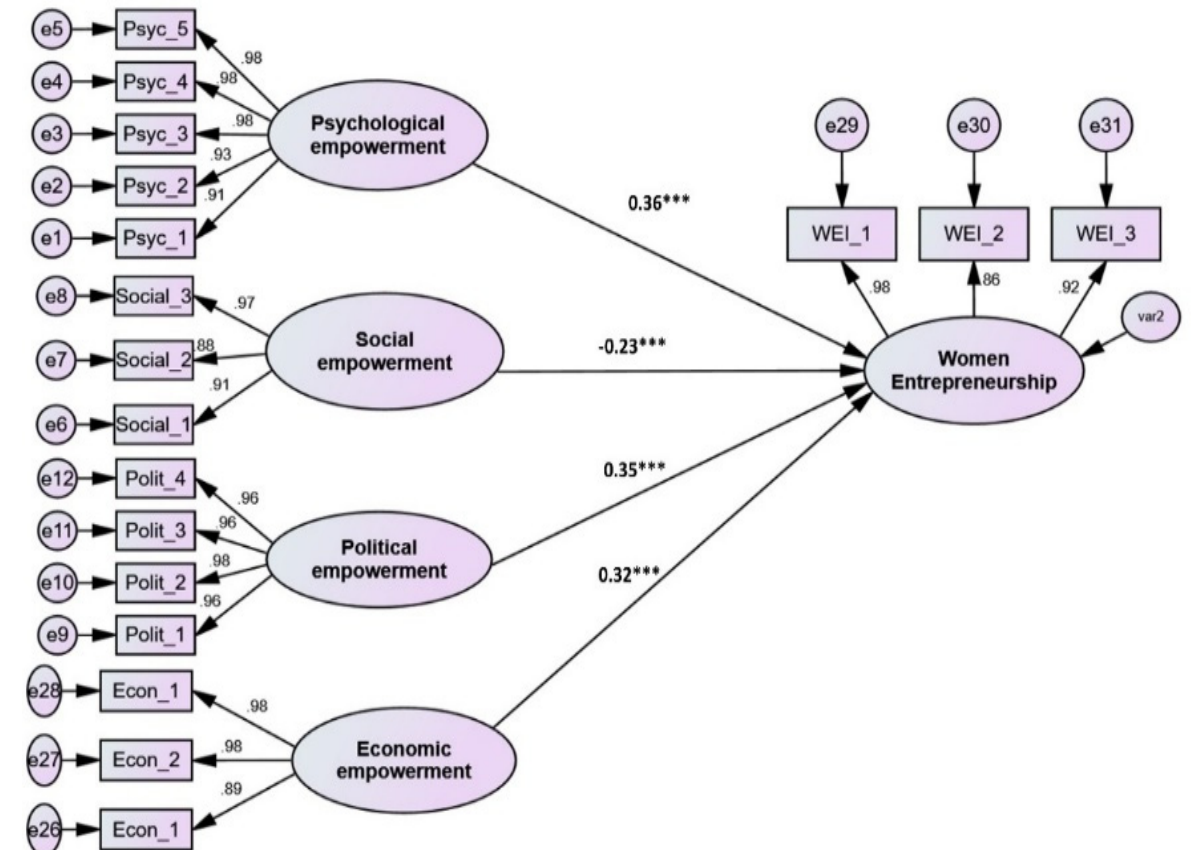
Figure 2. The study structural model. ***: significant level less than 0.001.